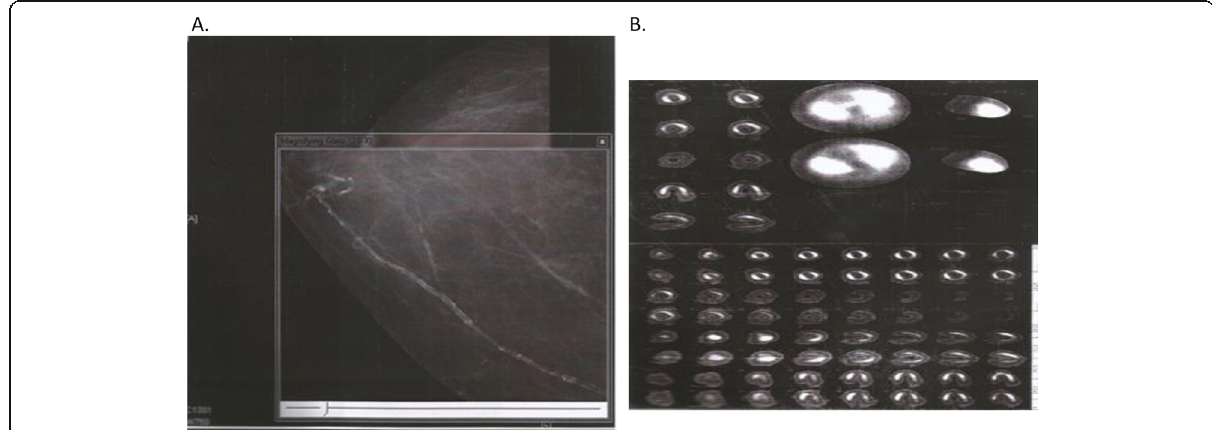
Fig. 1 a 58-year-old female patient with chest pain on rest and exertion. Her radioactive isotope scan showed ischemia and small scar at the LAD territory and mild ischemia at the RCA territories. CC mammography view showing unilateral BAC. b Showing thallium scan of the previously mentioned